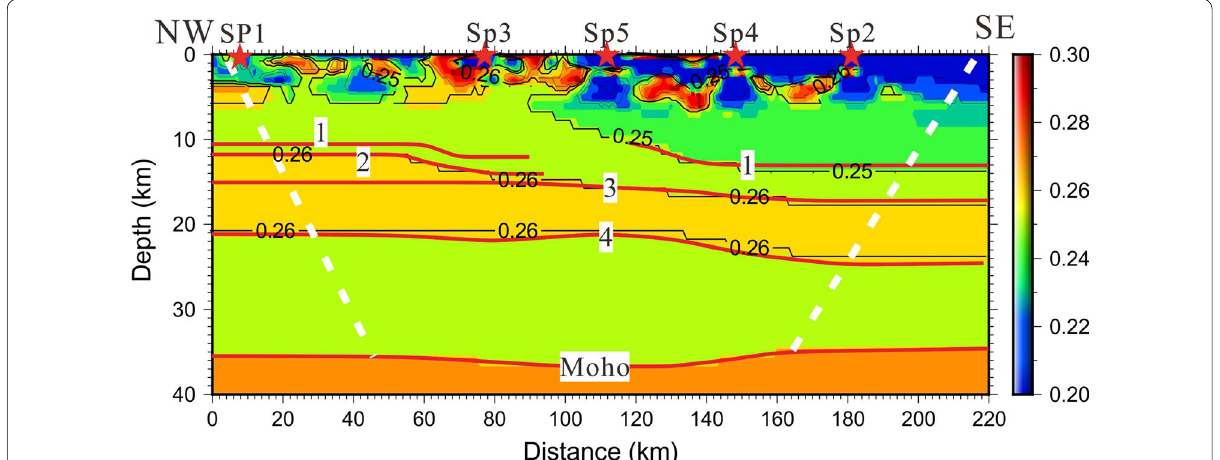
Fig. 12 a Black triangles indicate the observed Bouguer gravity anomalies and the red crosses indicate the calculated Bouguer gravity anomalies. b Density model used to calculate the Bouguer gravity anomalies. The density model is based on the P-wave seismic velocity structure in Fig. 8a. The numbers indicate the density (g/cm 3 ) of the